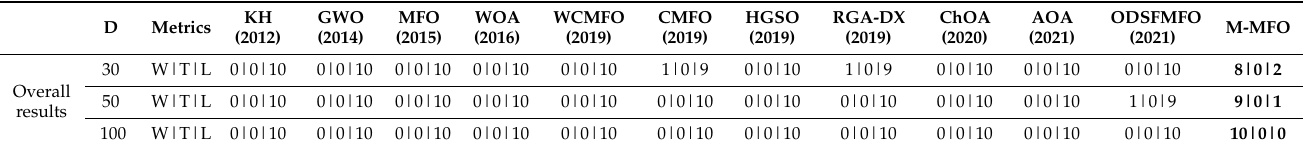
Table 4. The overall results of the M-MFO and comparative algorithms on hybrid test